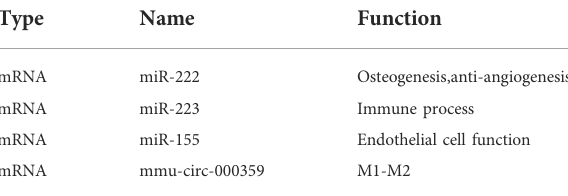
TABLE 1 Composition and function of macrophage